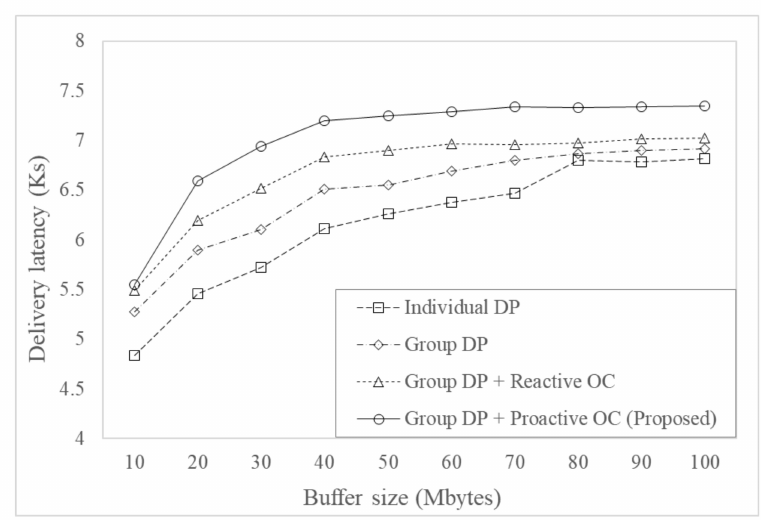
Figure 7. Delivery latency for varying buffer size.